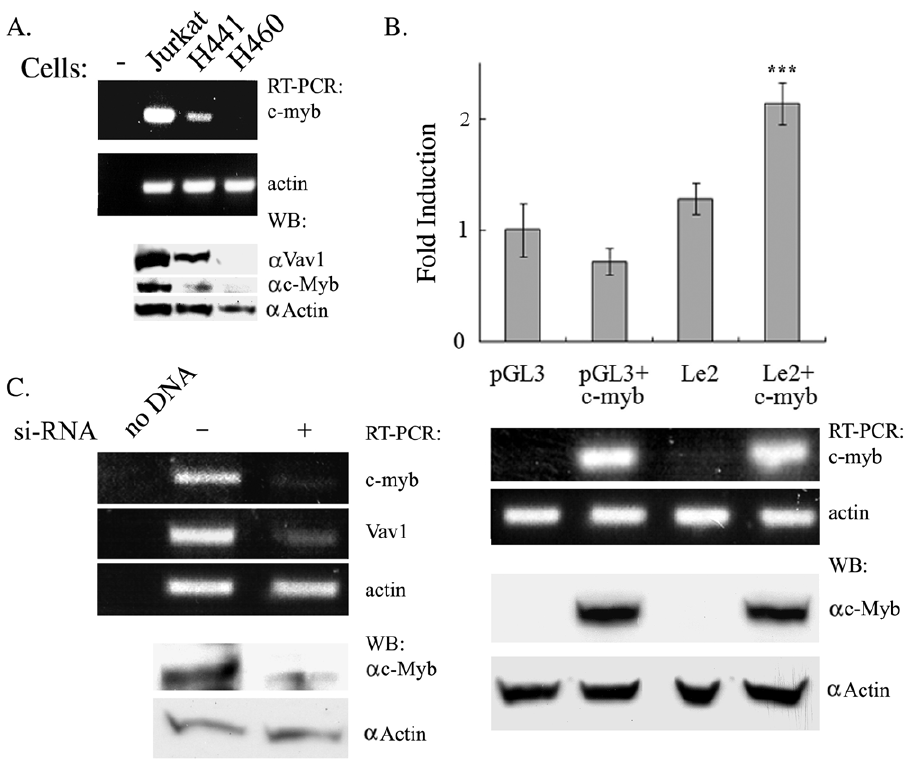
Figure 5. C-Myb is involved in regulation of vav 1 expression in lung cancer cells. (A) Endogenous expression of c-myb mRNA in Jurkat T cells, H441 ( vav 1-positive) and H460 ( vav 1-negative) lung cancer cell lines was detected by RT-PCR and western blotting. (B) Empty vector pGL3 or the Le2 wt reporter construct was transfected either alone or with a c-Myb-expressing plasmid into H460 lung cancer cells (as in Materials and Methods). Luciferase activity was measured 24 hr after transfection (top panel). Luciferase activity is expressed as fold induction relative to basic pGL3 expression. Values are the mean of five independent experiments; significance was determined using the unpaired student T test. (***) indicates p , 0.01. The bottom panel shows the level of c-myb and actin mRNA and protein expression in the transfected cells as determined by RT-PCR and Western blotting respectively. (C) H441 lung cancer cells were transfected with either scrambled DNA (-) or with siRNA against c-Myb. Seventy-two hours later, the mRNA levels of c-myb , vav1 and actin were detected by RT-PCR.